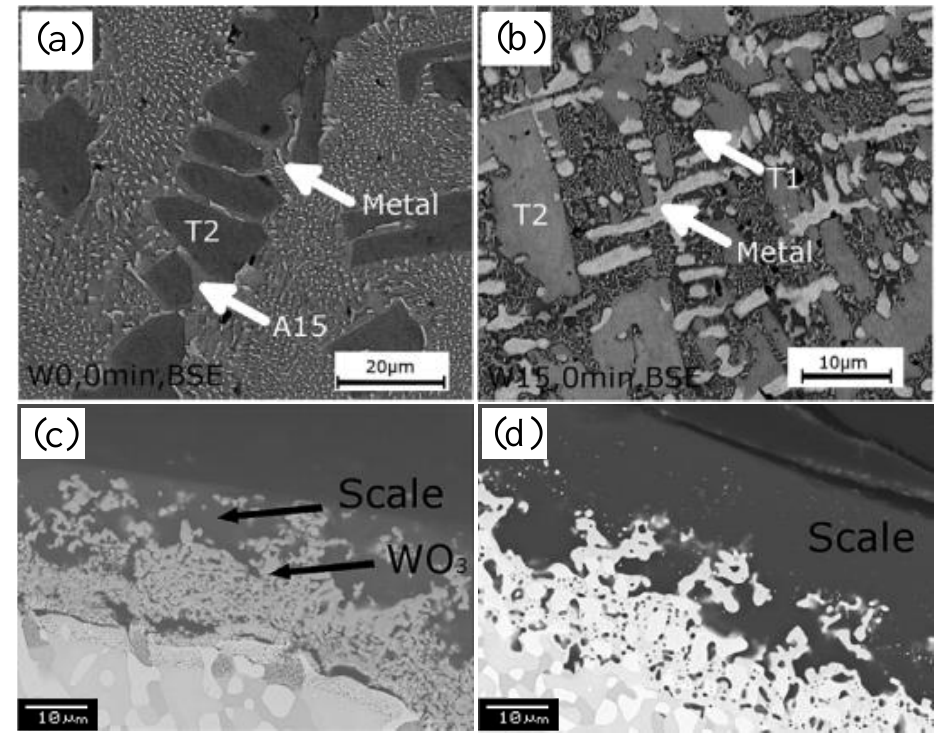
Figure 14. BSE images of the W0 ( a ) and W15 ( b ) surface prior to oxidation; Cross-sectional images of W15 after oxidation at 1200 °C ( c ) and 1500 °C ( d ) for 2 h. Reproduced with permission [70]. Copyright 2017 Elsevier.